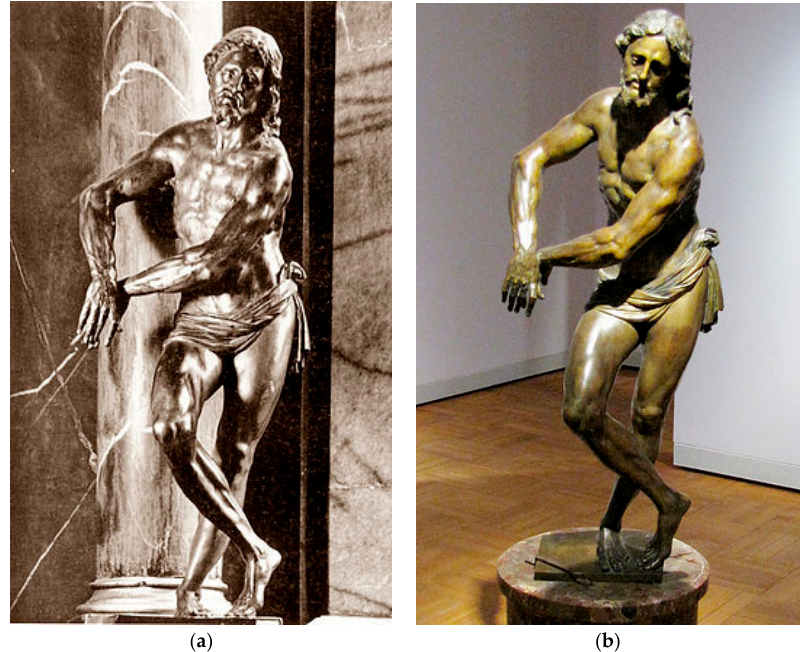
Figure 2. A statue of Christ being scourged from the tombstone of Adam von Hanniwaldt and his wife